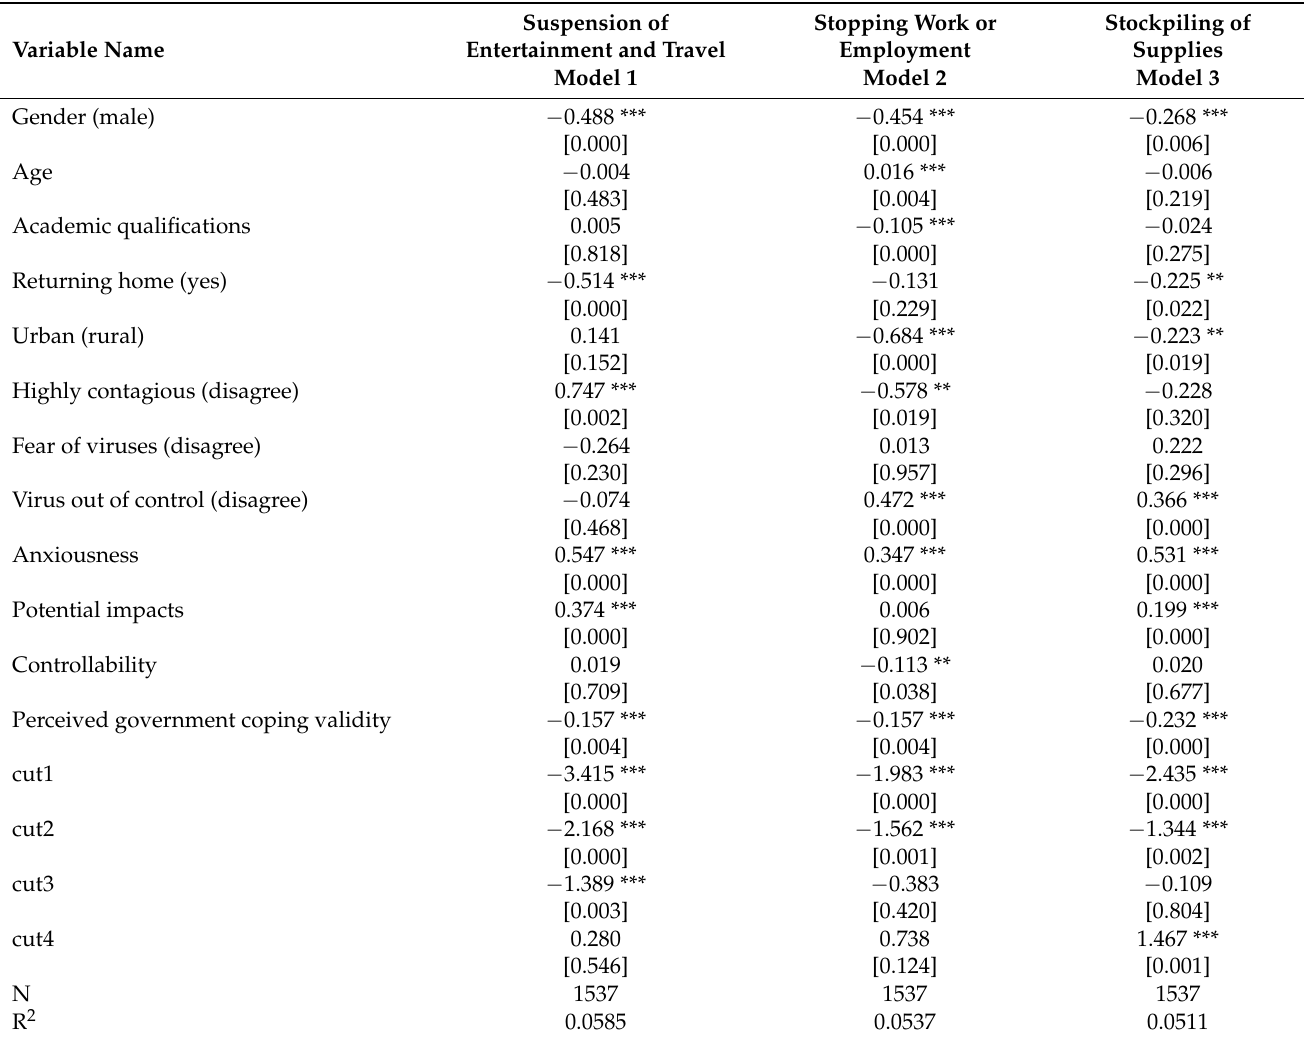
Table 3. Ordered logistic regression model of individual